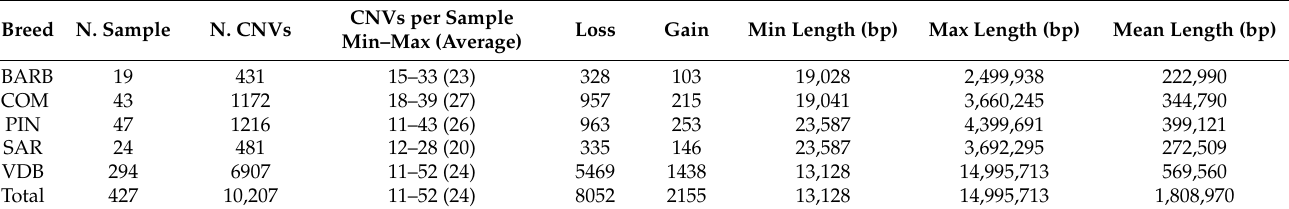
Table 1. Summary of CNVs identified in each breed.